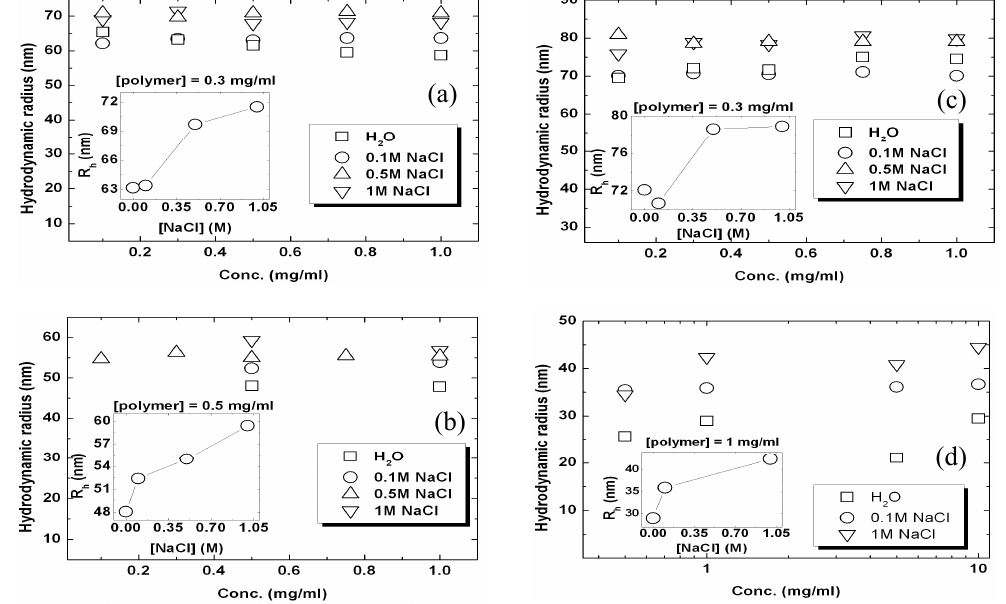
Figure 7. Polymer concentrations dependence of hydrodynamic radius: ( a ) n -BMA 62 - b -GLBT 117 ; ( b ) n -BMA 101 - b -GLBT 156 ; ( c ) n -BMA 42 - b -GLBT 300 ; and ( d ) EHA 20 - b -GLBT 156 . Inset shows variation of hydrodynamic radius with different concentrations of sodium chloride. Table 1. Effect of hydrophobicity and salt on dissymmetry ratio and polydispersity indices of the micelles.